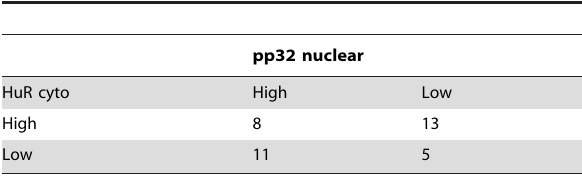
Table 3. Correlation between pp32 and HuR subcellular localization.